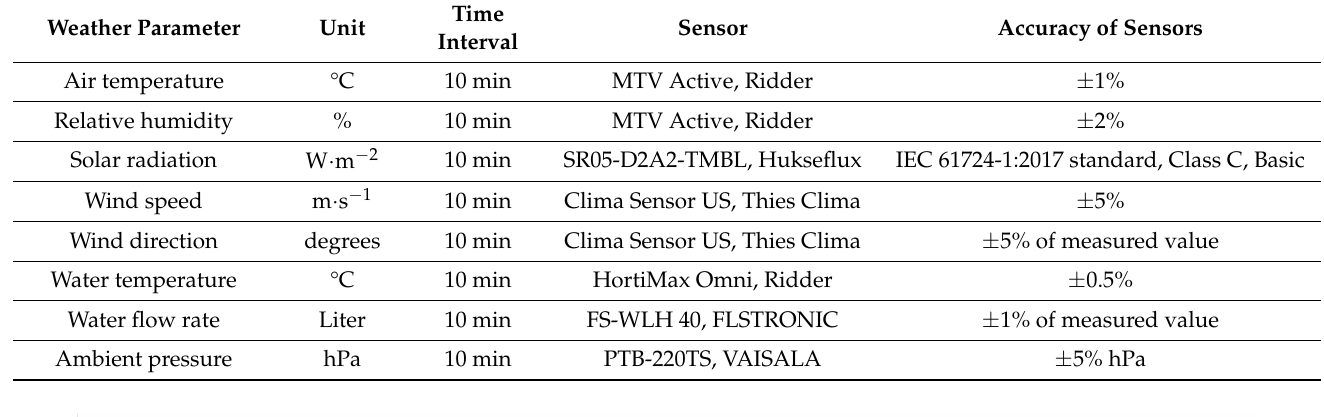
Table 1. Characteristics of the recorded weather data.